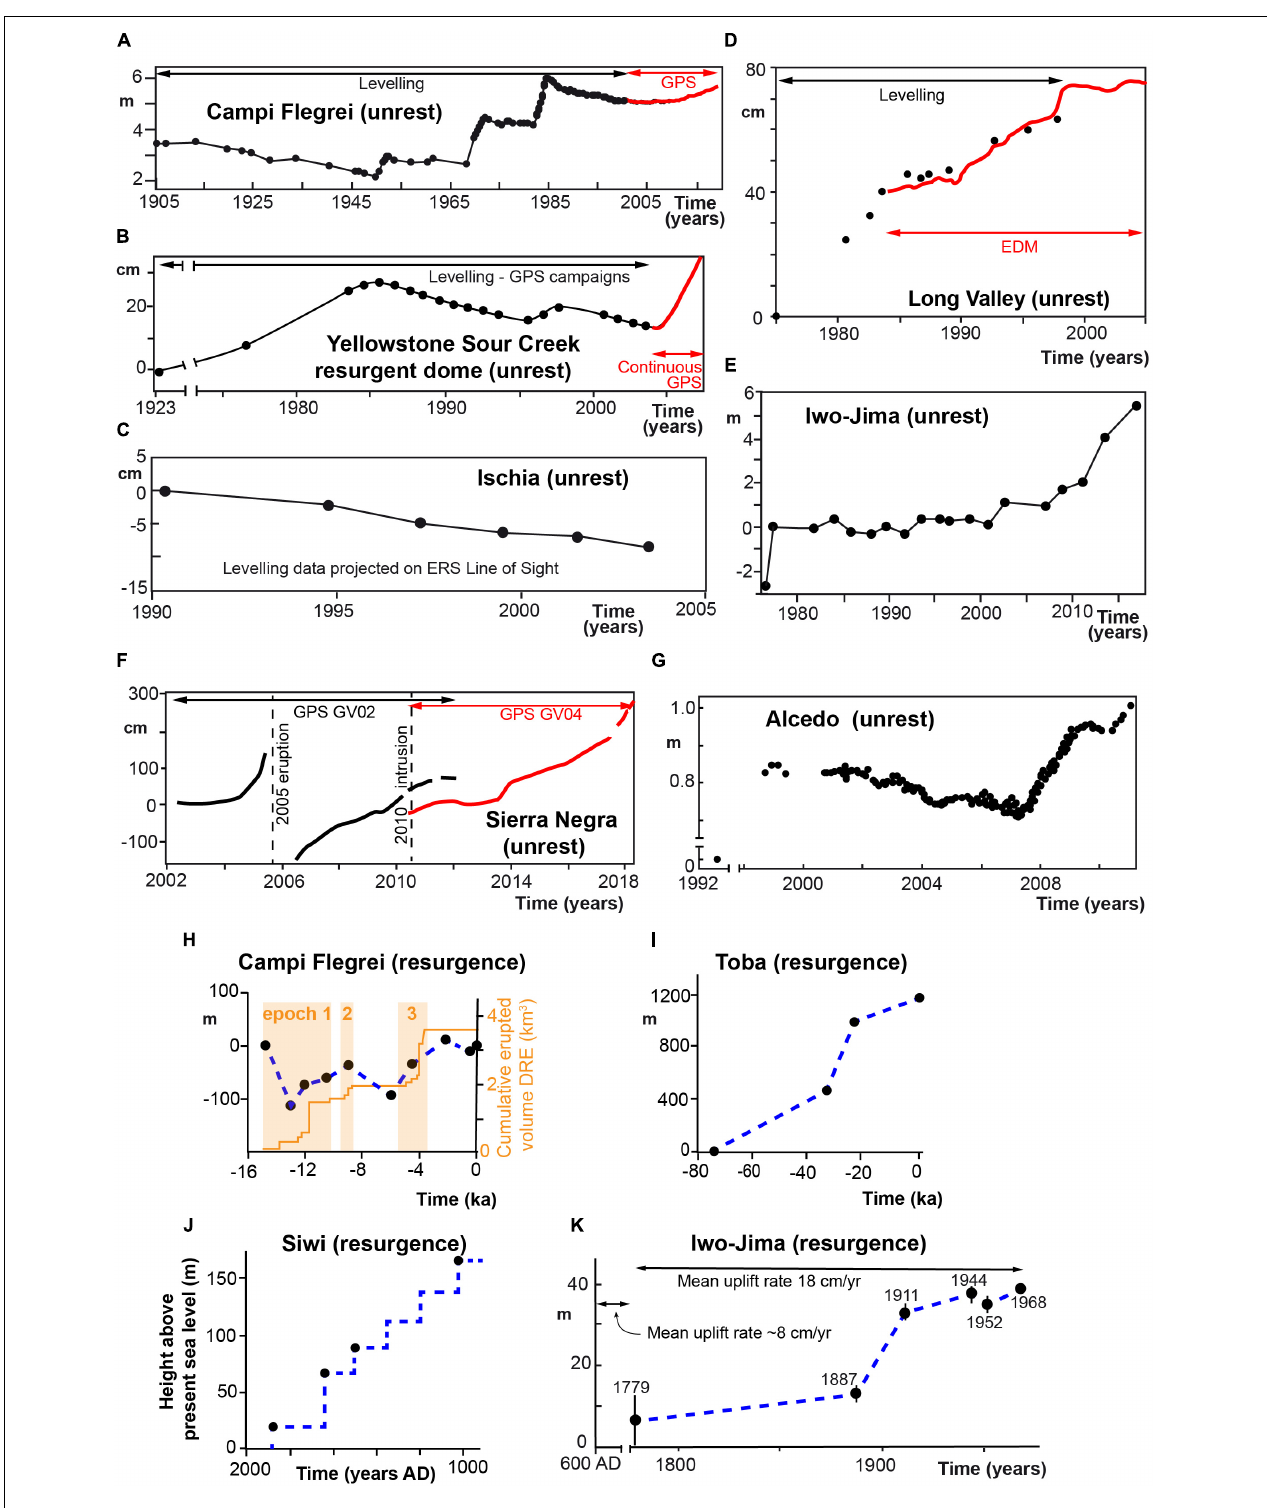
FIGURE 1 | Available curves of vertical deformation (specified on the Y -axis if in m or cm; except case j) through time during unrest episodes or resurgence at several calderas. (A–G) short-term vertical displacement of monitored felsic (A–E) and mafic (F,G) resurgent calderas experiencing unrest. (H–K) Available curves of variation in the long-term vertical displacement of felsic resurgent calderas; in the Campi Flegrei case (H) the eruptive periods (orange bands) and cumulative erupted products (orange curve) are included. See text for references.